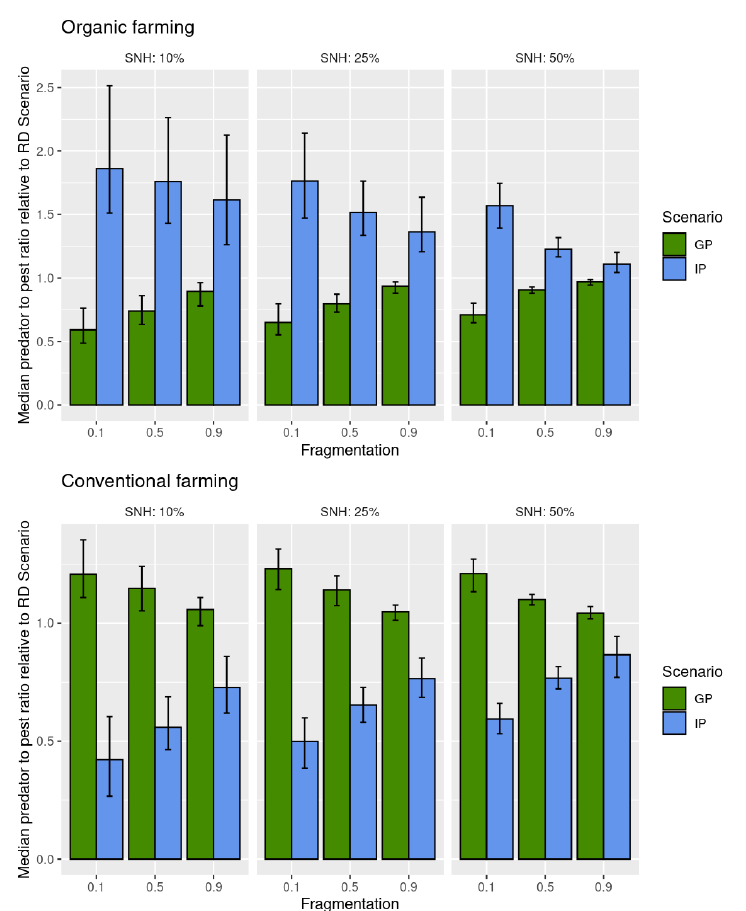
Figure 6 . Median predator to pest ratio at t=50 in organic and conventional crops for the IP and GP scenarios relative to the ratio obtained for the RD scenario with the same parameter values. Error bars represent first and third quartiles over all combinations of population dynamic